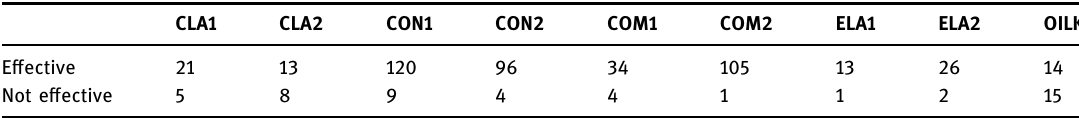
Table 3: Frequency in which NOM strategies are e ff ective and not e ff ective CLA1 CLA2 CON1 CON2 COM1 COM2 ELA1 ELA2